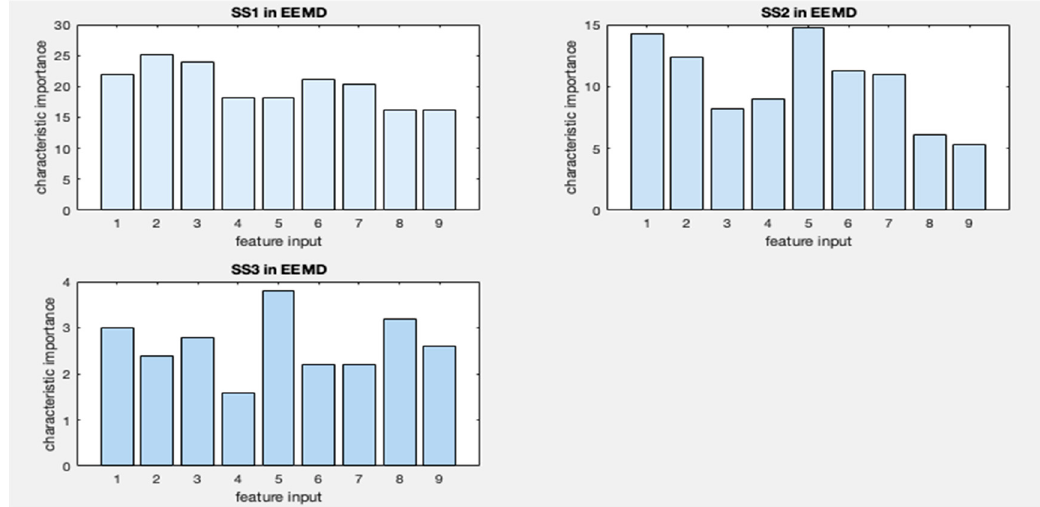
Table 2. Input factors for random forest analysis selection of “Yangdong Line.”